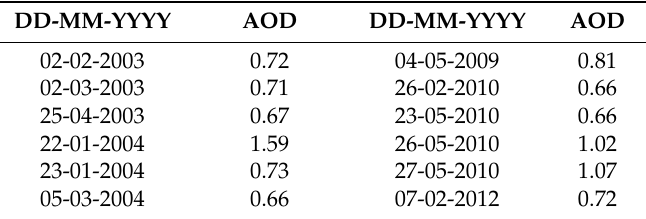
Figure 3. Average (2003–2014) seasonal cycle of AOD over Egypt for winter (DJF), spring (MAM), summer (JJA), and fall (SON). Table 3. Chronology of 33 SAPEs occurred over the geographic domain of Egypt during the study period, obtained from the time series of daily record of AOD at 550 nm.